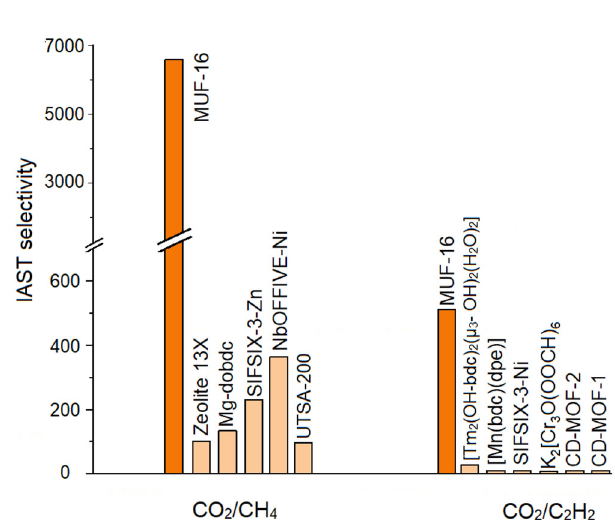
Fig. 5 Separation performance of MUF-16 compared to top- performing materials. IAST selectivity of MUF-16 in comparison to a selection of physisorbents for CO 2 /CH 4 (50/50) and CO 2 /C 2 H 2 (50/50) mixtures at ambient temperature and 1 bar (see Supplementary Table 11 for details). For clarity, the y axis is broken in two parts with different